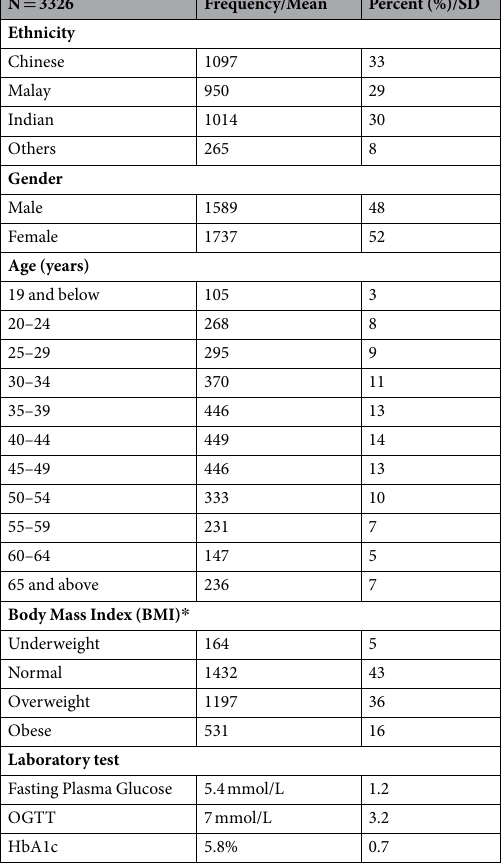
Table 1. Demographic characteristics of participants included in this study. * 2 subjects did not have their BMI recorded in the